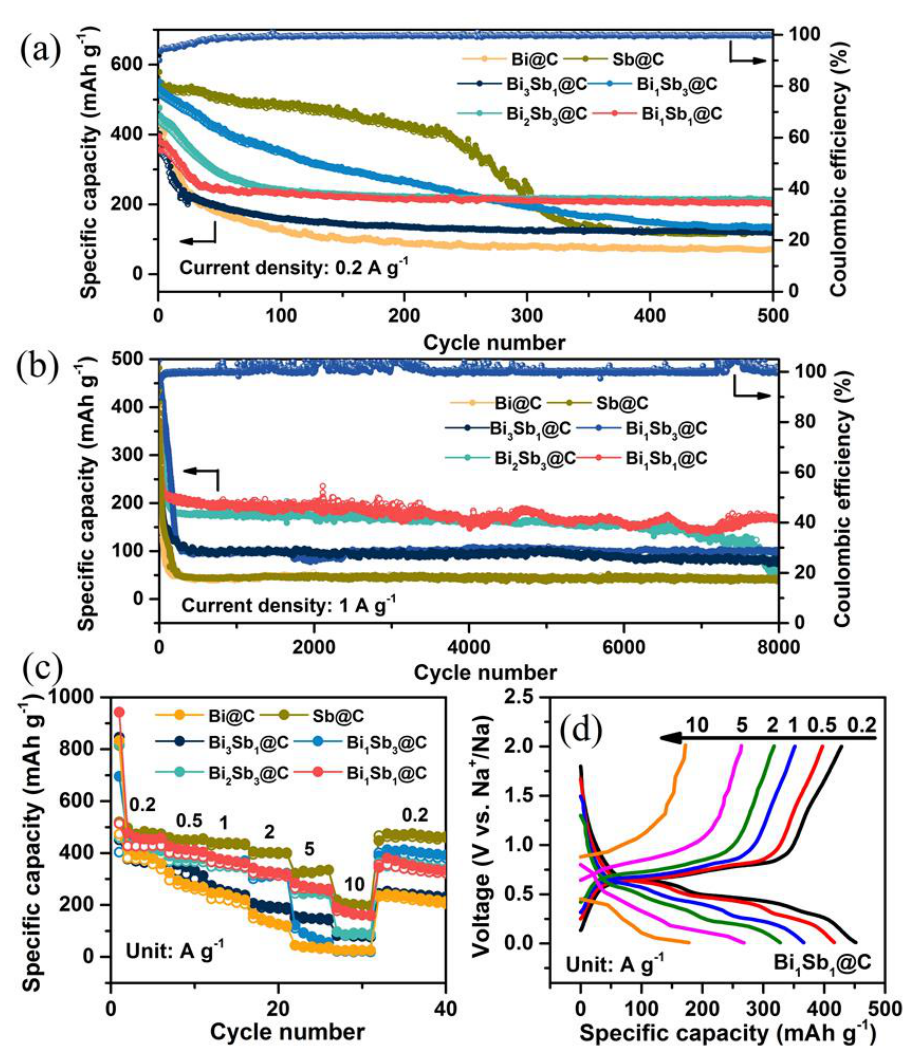
Figure 4. Na storage performance of the Bi−Sb@C samples. Cycling stability of the Bi−Sb@C samples